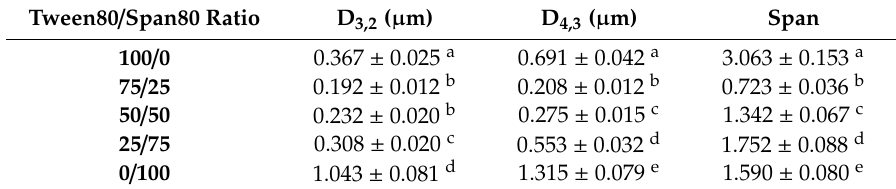
Table 2. Influence of Tween80 / Span80 ratio on Sauter diameter ( D 3,2 ), volumetric diameter ( D 4,3 ), and span values. a–e Mean value ± standard deviation; values without common superscripts within the same column were significantly different ( p < 0.05).